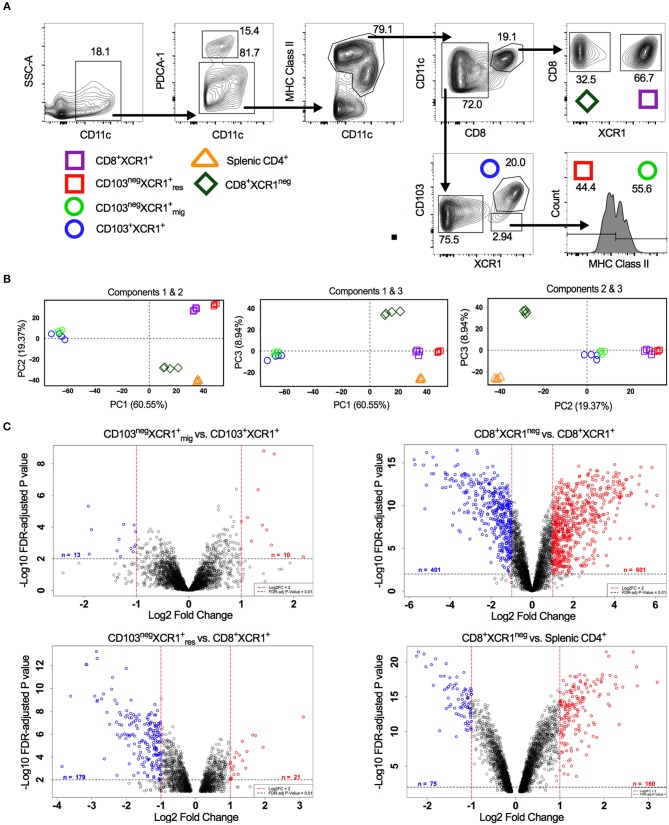
Analysis of DC subset relatedness in the skin-draining lymph nodes reveals differences in gene expression profiles of CD8+XCR1neg and CD8+ XCR1+ DCs. (A) Gating strategy used to identify and sort dendritic cell subsets for microarray analysis. (B) RNA was extracted from sorted DC subsets and analyzed with the Affymetrix Mouse Gene 2.0 ST array. Principle component analysis of the first three components. CD8+XCR1neg subset (diamond), XCR1+ resident subsets (squares), XCR1+ migratory subsets (circles) and splenic CD4+ subset (triangle). (C) Volcano plots displaying differential gene expression between related migratory and resident DC subsets. Red dashes represent log2FC>1 and black dashes represent adjusted P-value <0.01. Numbers of differentially expressed genes are indicated on each plot. Red labeled genes are up-regulated and blue labeled genes are down-regulated relative to the population indicated first in the title.